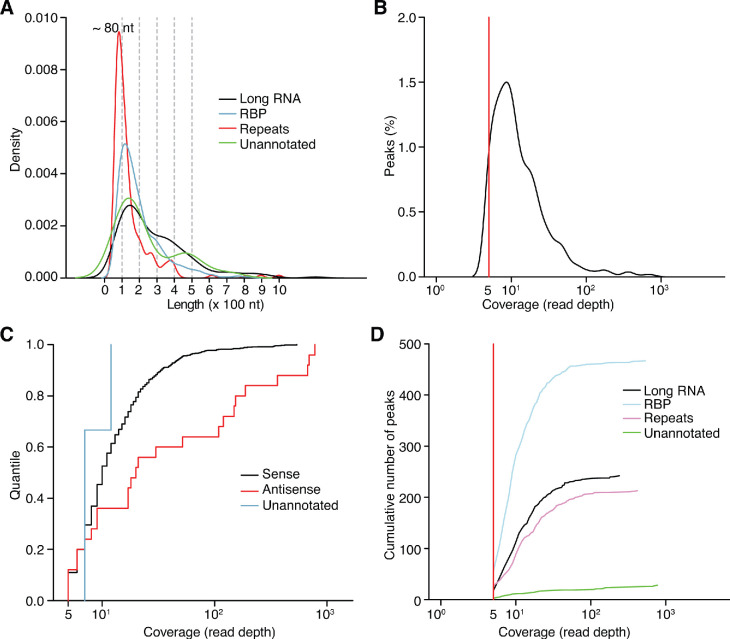
Characteristics of different categories of peaks identified by MACS2 peak calling analysis of combined datasets of DNase-treated plasma RNA (n = 15).(A) Density plot showing the range of peak lengths computed from the genomic positions at the beginning and end of each peak. (B) Distribution plot of the number of reads mapping within the called peaks. (C) Empirical cumulative distribution plots of read coverage for different categories of peaks. Peaks that overlapped annotated features on the sense strand were classified as ‘Sense’; peaks on the antisense strand that overlapped annotated sense-strand feature were classified as ‘Antisense’; and the remainder of the peaks were classified as ‘Unannotated’. (D) Cumulative peak count with increasing coverage threshold. Plots are color-coded by peak type as indicated in the Figure. In panels (B) and (D), the red vertical line represents the coverage cutoff for significant peaks (coverage ≥ 5 deduplicated reads).